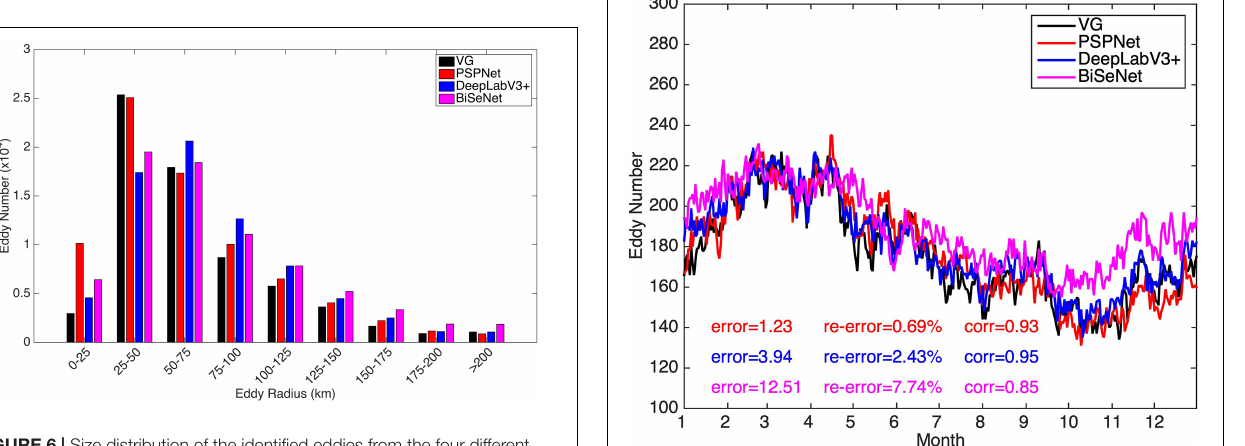
FIGURE 6 | Size distribution of the identified eddies from the four different algorithms in the STCC region during 2015. Black, red, blue, and purple bars represent the results from VG, PSPNet, DeepLabV3+, and BiSeNet algorithm, respectively.